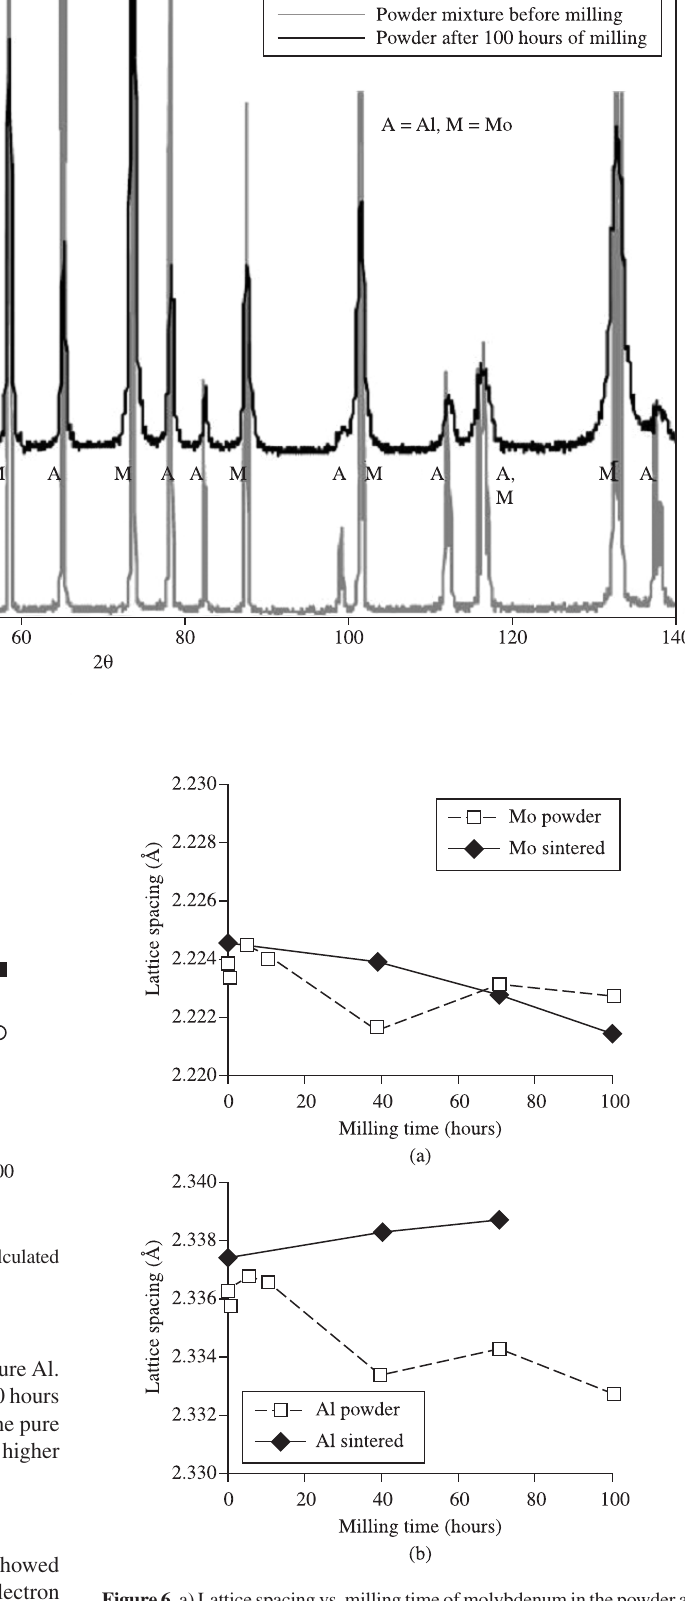
Figure 6. a) Lattice spacing vs. milling time of molybdenum in the powder and in the compacted and sintered specimens; b) lattice spacing vs. milling time of aluminum in the powder and in the compacted and sintered